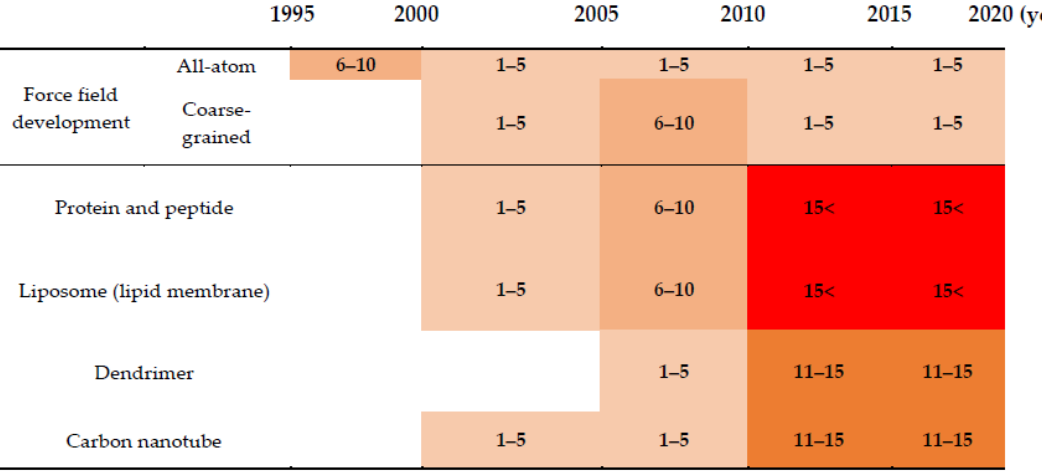
Figure 1. Number of publications on the force-field development and molecular dynamics simulations of polyethylene glycol (PEG)ylated biomolecules and nanoparticles (the numbers